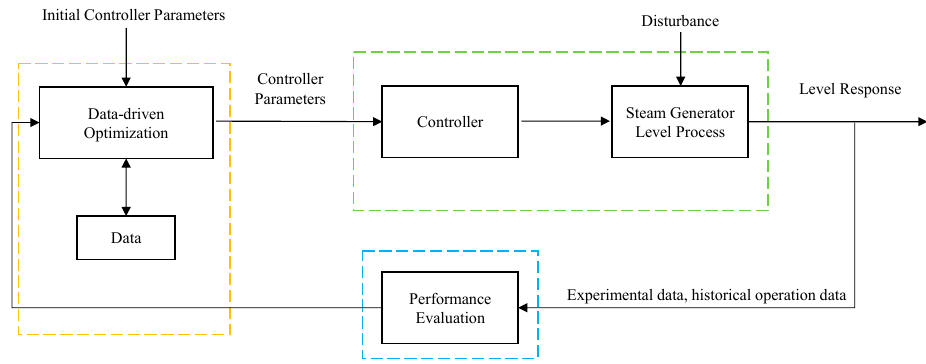
Figure 5. Structure of data − driven performance optimization strategy for the SGLCS.